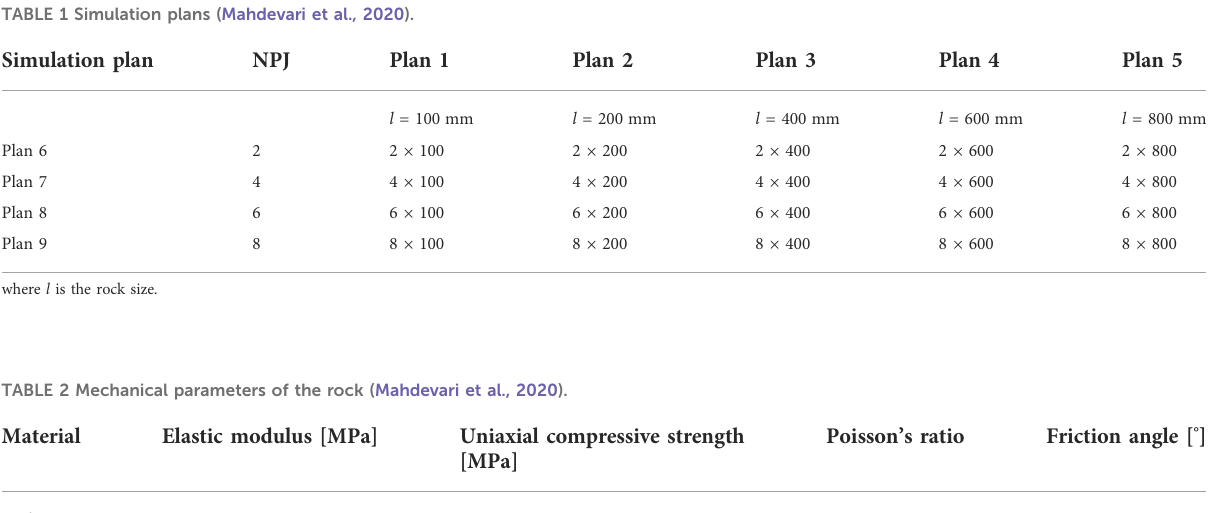
TABLE 1 Simulation plans (Mahdevari et al., 2020).